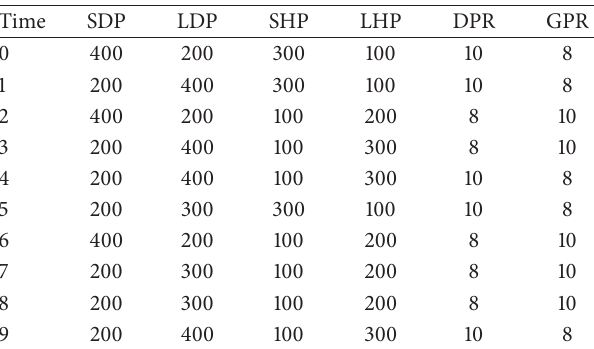
Table 2: Case study values